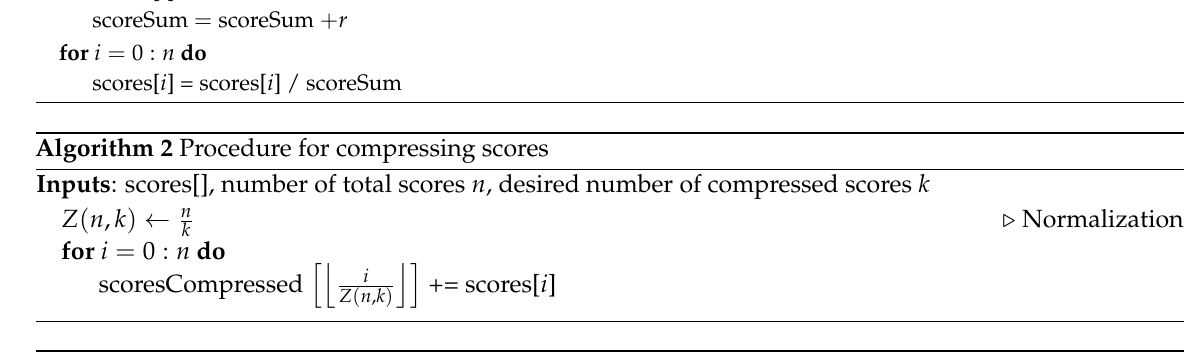
Algorithm 3 Procedure for generating scores in a Gaussian